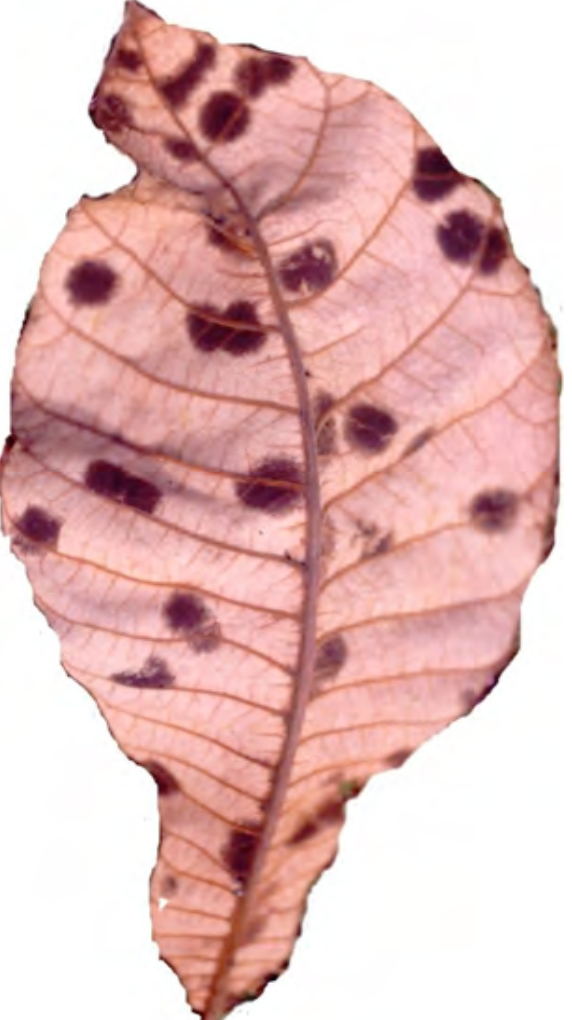
Fig.-81. Meliola holigarnae a - Appressorium; b - Phialide; c - Apical portion of mycelial setae; d - AscosporesImage. 8. Meliola holigarnae -Infected